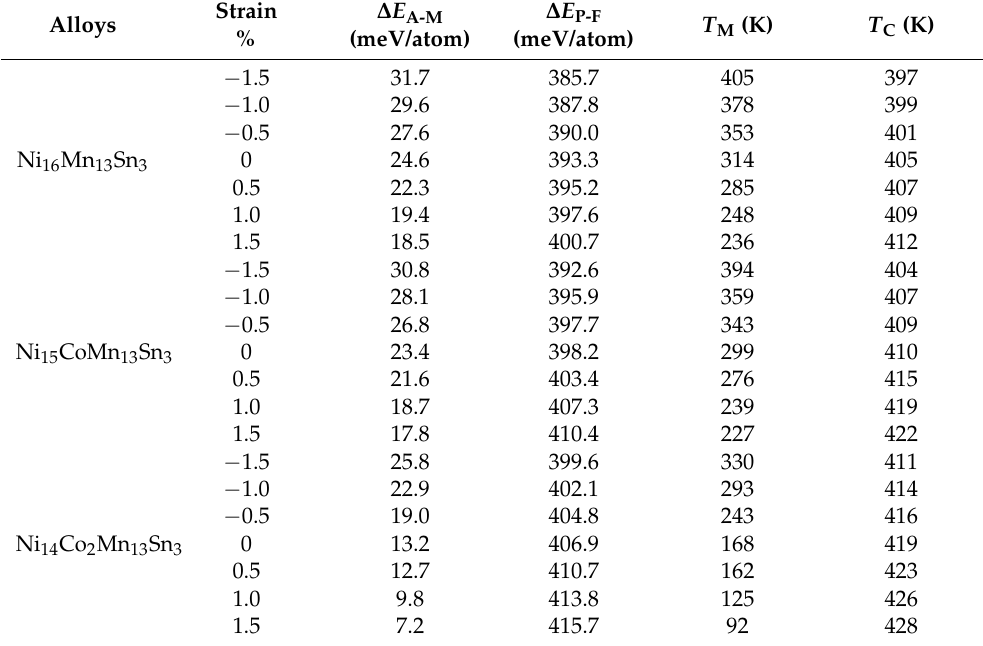
Table 2. Calculated energy difference ∆ E A-M in meV/atom between the austenite and martensite phases, ∆ E P-F in meV/atom between the paramagnetic and ferromagnetic state, martensite tran- strain ( −